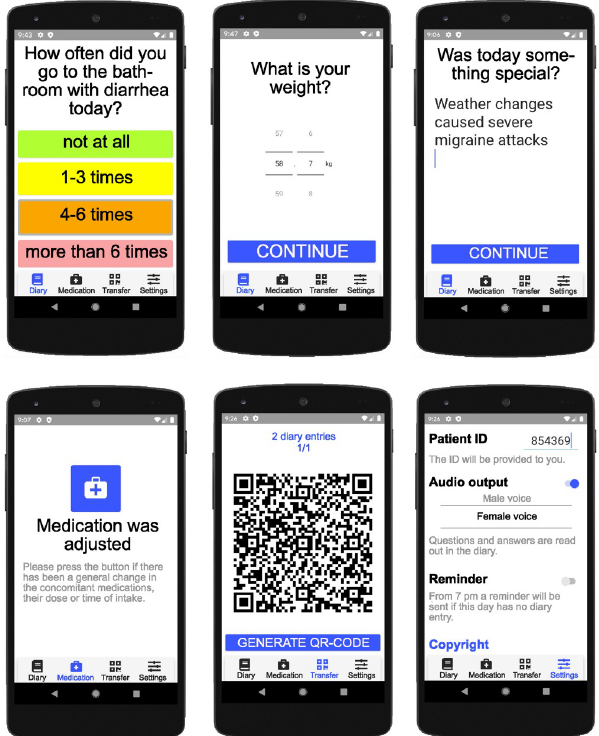
Fig 3. NEMO smartphone app. (a) In the settings, users can choose between two therapy schemes and the corresponding questionnaires as well if they want a reminder to daily answer the questionnaire or whether they prefer to hear possible answers with a male or female voice. (b) If the smartphone app opens, the questionnaire about occurred adverse events can be started by clicking on the plus button. (c,d) Each issue is depicted on an independent site and can be passed by answering the question. An obvious color scheme with high contrast indicates the scoring of the side effect. (e) Information about the current weight or pulse can be entered with a predefined picker to avoid misinterpretation by different scales. (f) Furthermore, patients can enter a comment. (g) At the end of the questionnaire, all given answers are summarized and can be changed if the answer is not correct. (h) If the family doctor adjusts the medication, the physician in the clinic can be informed by pressing the button “medication changed”. The meaning of buttons and settings is explained by short descriptions (e.g. please press the button if there was a general change for